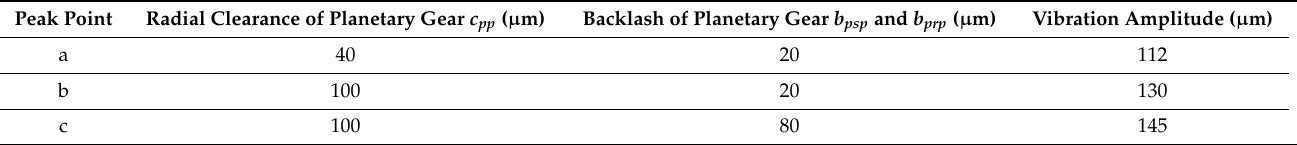
Table 9. The peak value of torsional vibration for antenna reflector in Figure 16.